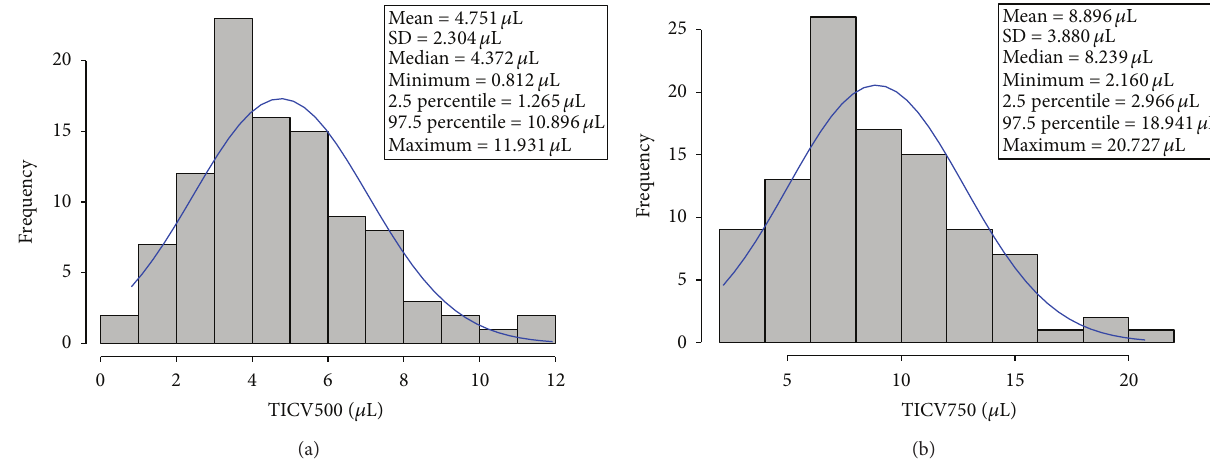
Figure 2: (a) Histogram and estimated density function for TICV500. (b) Histogram and estimated density function for TICV750.